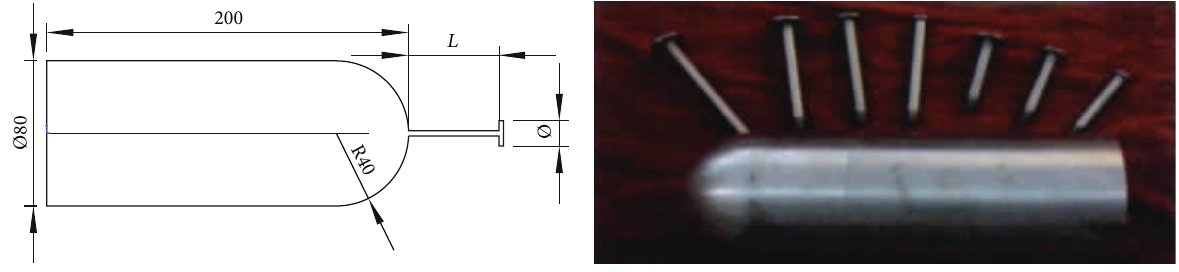
Figure 2: Photo of the basic model and tip spikes (unit: millimeter) [32]. Table 1: Flow conditions of